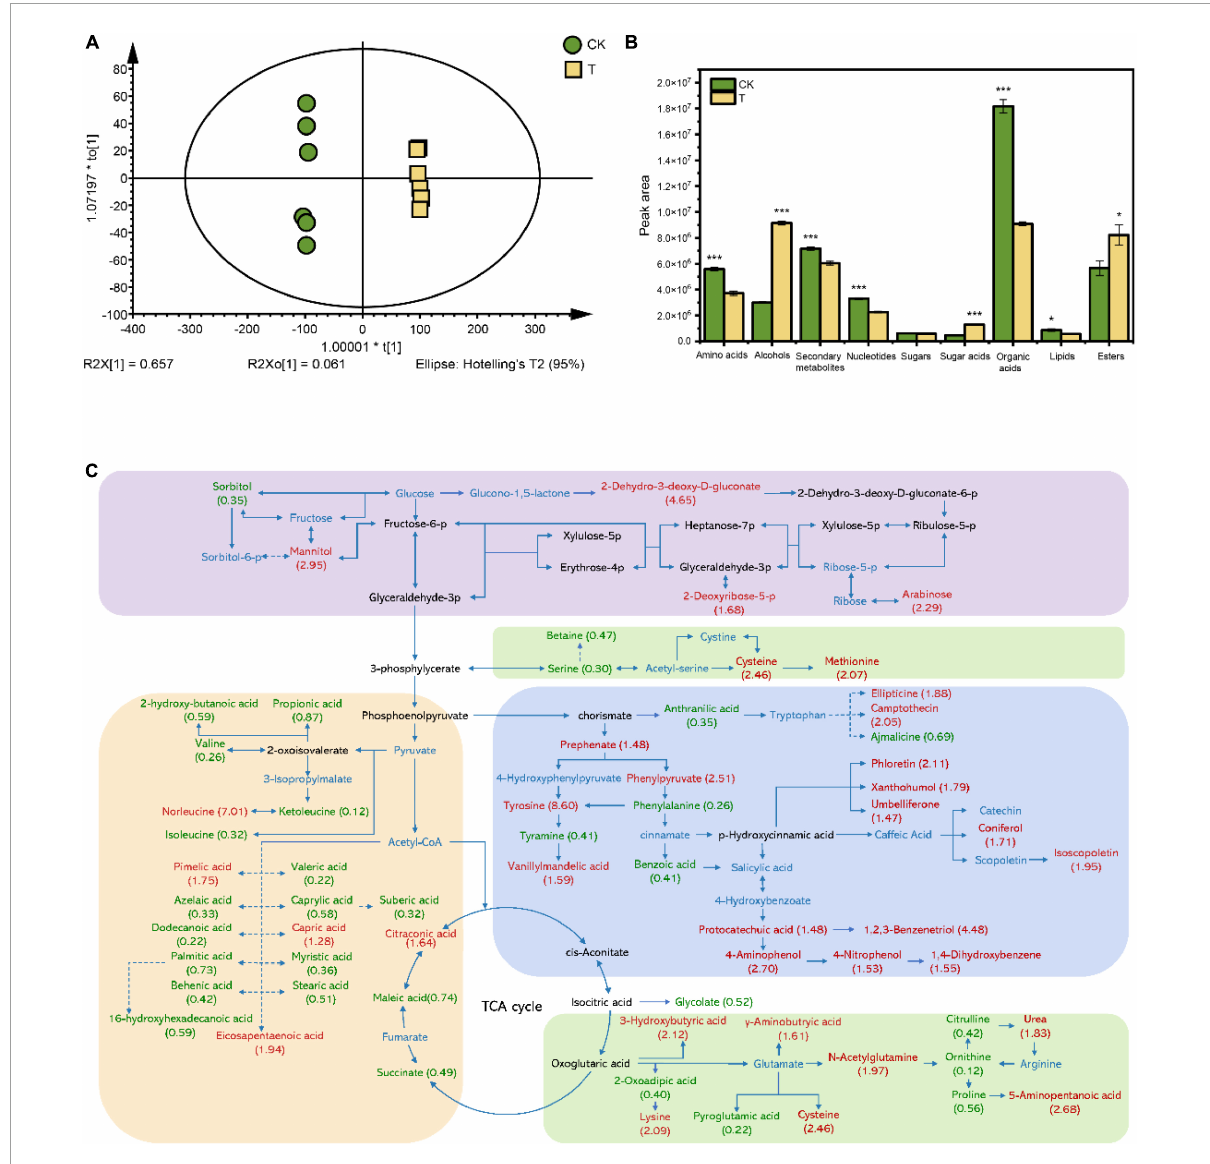
FIGURE6 (A) Score scatter plot of the OPLS-DA model for identified root exudate differences in the control and 4-HBA treatments. The scatter shape and color represent different experimental groups. CK: Control; T: 4-HBA treatment. (B) Peak area of differential metabolite categories. Each bar represents the average of six replicates. The asterisk indicates statistically significant differences between CK and 4-HBA treatment (Student’s t -test, * p < 0.05; *** p < 0.001). (C) Effects of 4-HBA treatment on the metabolic pathways involving grapevine root exudates. The metabolites in the blue text were detected in the present experiment; the metabolites in red or green text represent significantly upregulated ( p < 0.05) or downregulated ( p < 0.05) metabolites compared with CK. The solid and dashed lines represent direct and indirect metabolite pathways, respectively. Numbers in parentheses represent FC values. The figure has been made readable by roughly separating the metabolites into carbohydrate, organic acid, amino acids, and secondary metabolites metabolism, as shown by the purple, yellow, green, and blue rectangle